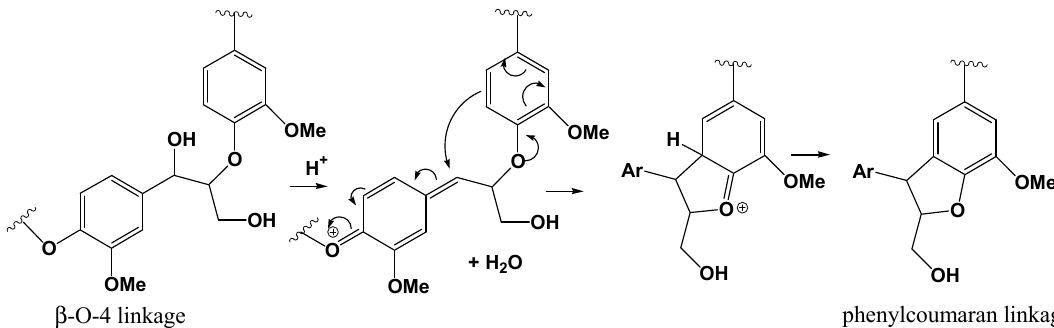
Figure 8. Acid-catalyzed mechanism of formation of a linear polyphenylcoumaran macromolecule.